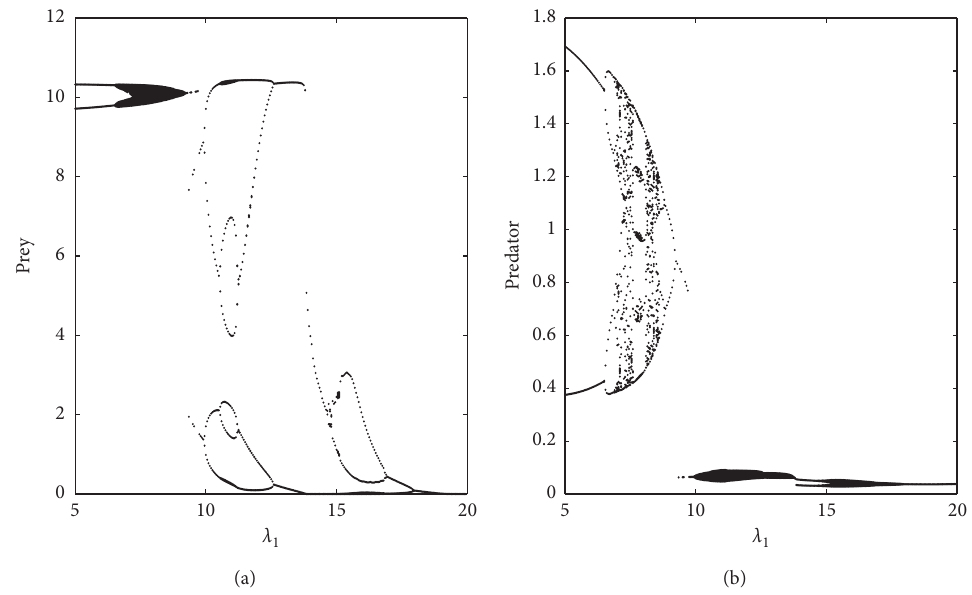
Figure 3: Bifurcation diagrams of model (1) with respect to λ